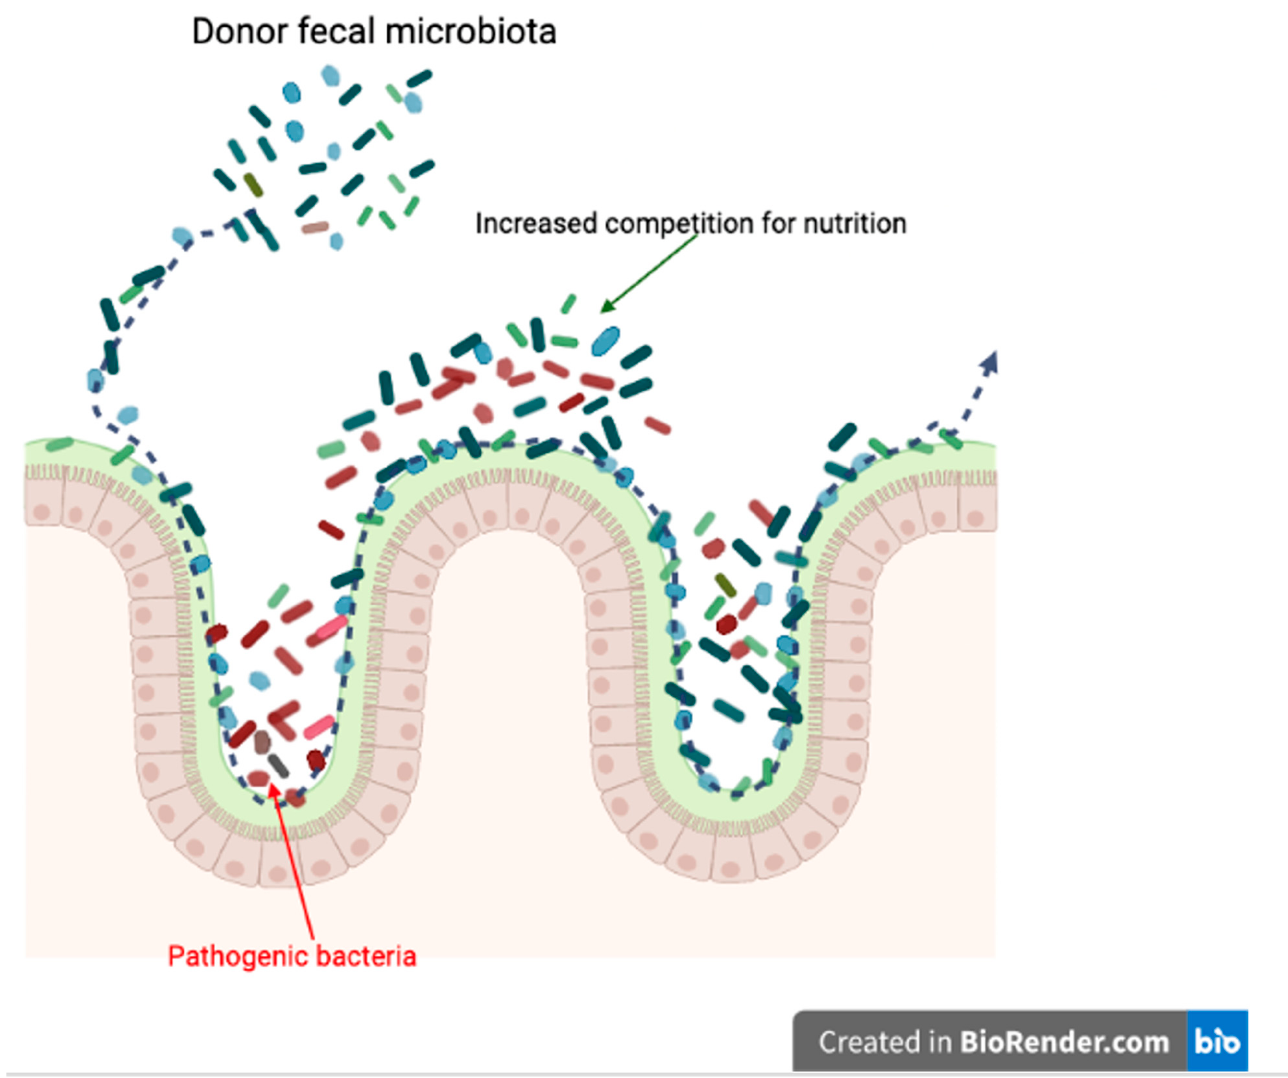
Figure 3. Potential mechanism of FMT; increased competition for nutrition. (Created with BioRender.com, accessed date 18 June